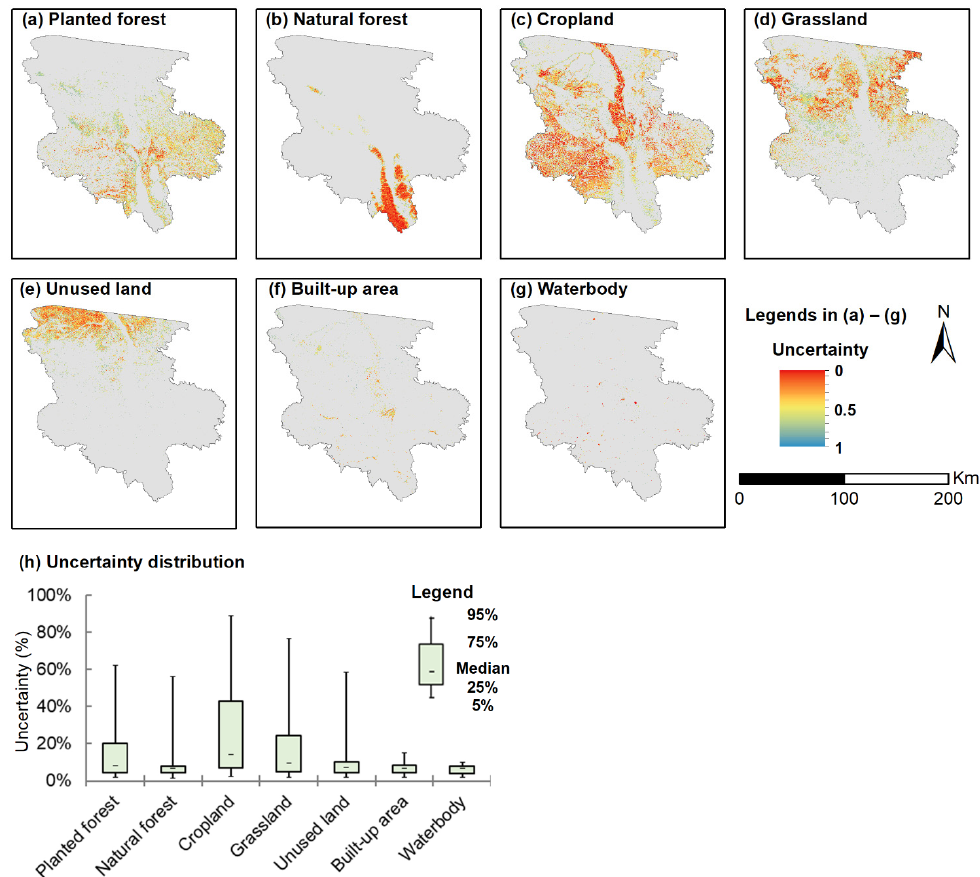
Figure 6. U ncertainties of a given pixel belonging to ( a ) planted forest, ( b ) natural forest, ( c ) cropland, ( d ) grassland, ( e ) unused land, ( f ) built-up area, and ( g ) waterbody, together with an ( h ) uncertainty distribution of the seven land cover types.